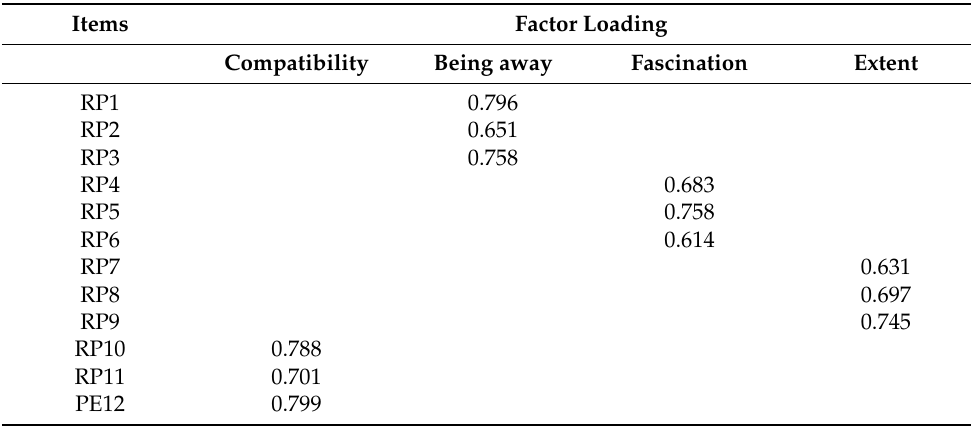
Table 4. Rotating component matrix of the restorative perception of the